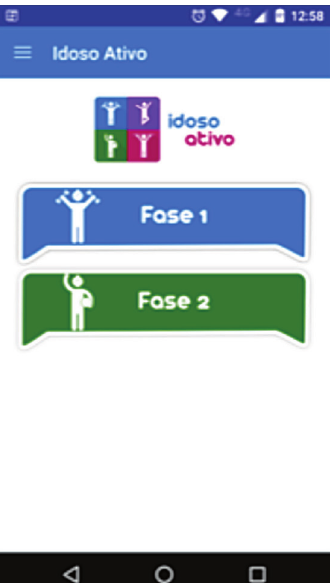
Figure 2 - Presentation for phase selection.